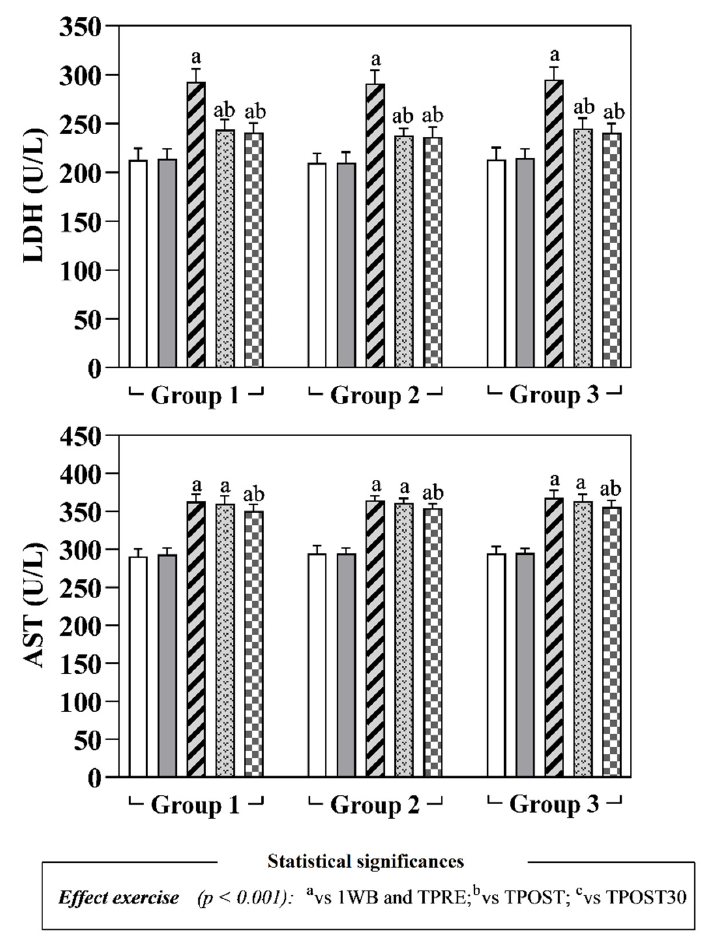
Figure 3. Mean values ± standard deviation (±SD) of serum creatine kinase (CK), aspartate aminotransferase (AST) and lactate dehydrogenase (LDH) measured 1 week prior to the race (1WB), the day of the race at rest (TREST), immediately after the race (TPOST), and after 30 (TPOST30) and 120 min (TPOST120) in Thoroughbred racehorses belonging to Group 1 (1200 m race), Group 2 (1600 m race) and Group 3 (2000 m race).